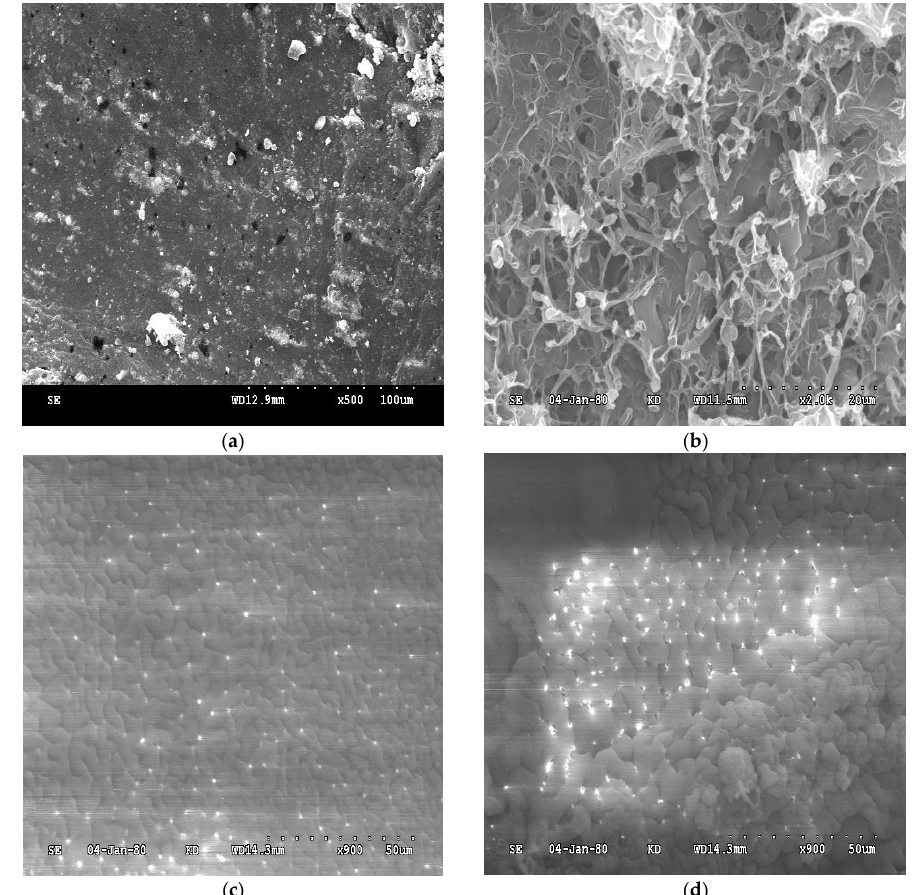
Figure 7. SEM image of the internal pore structure: ( a ) before soaking; ( b ) soaking for 5 days; ( c ) soaking for 10 days and ( d ) soaking for 15 days.